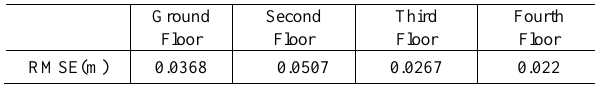
Table 1. Co-registration accuracy of each floor